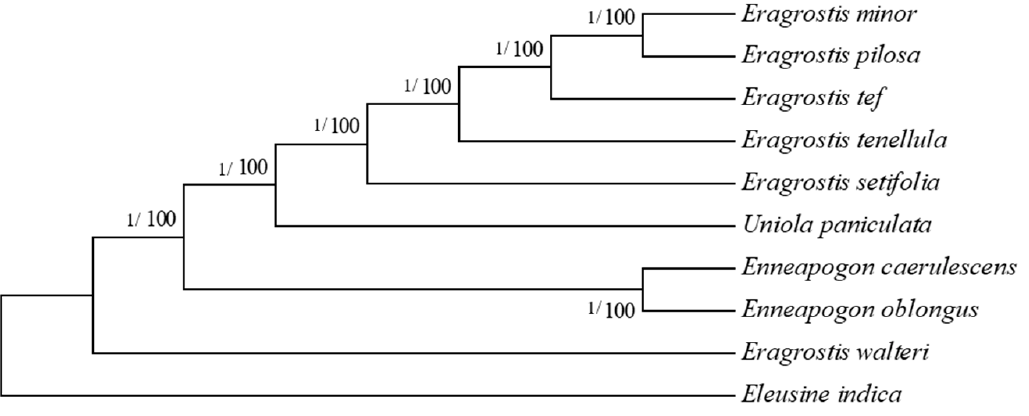
Figure 7. Phylogenetic trees based on ML and BI analysis on whole cp genome sequences Bootstrap values and posterior values are shown in each node.